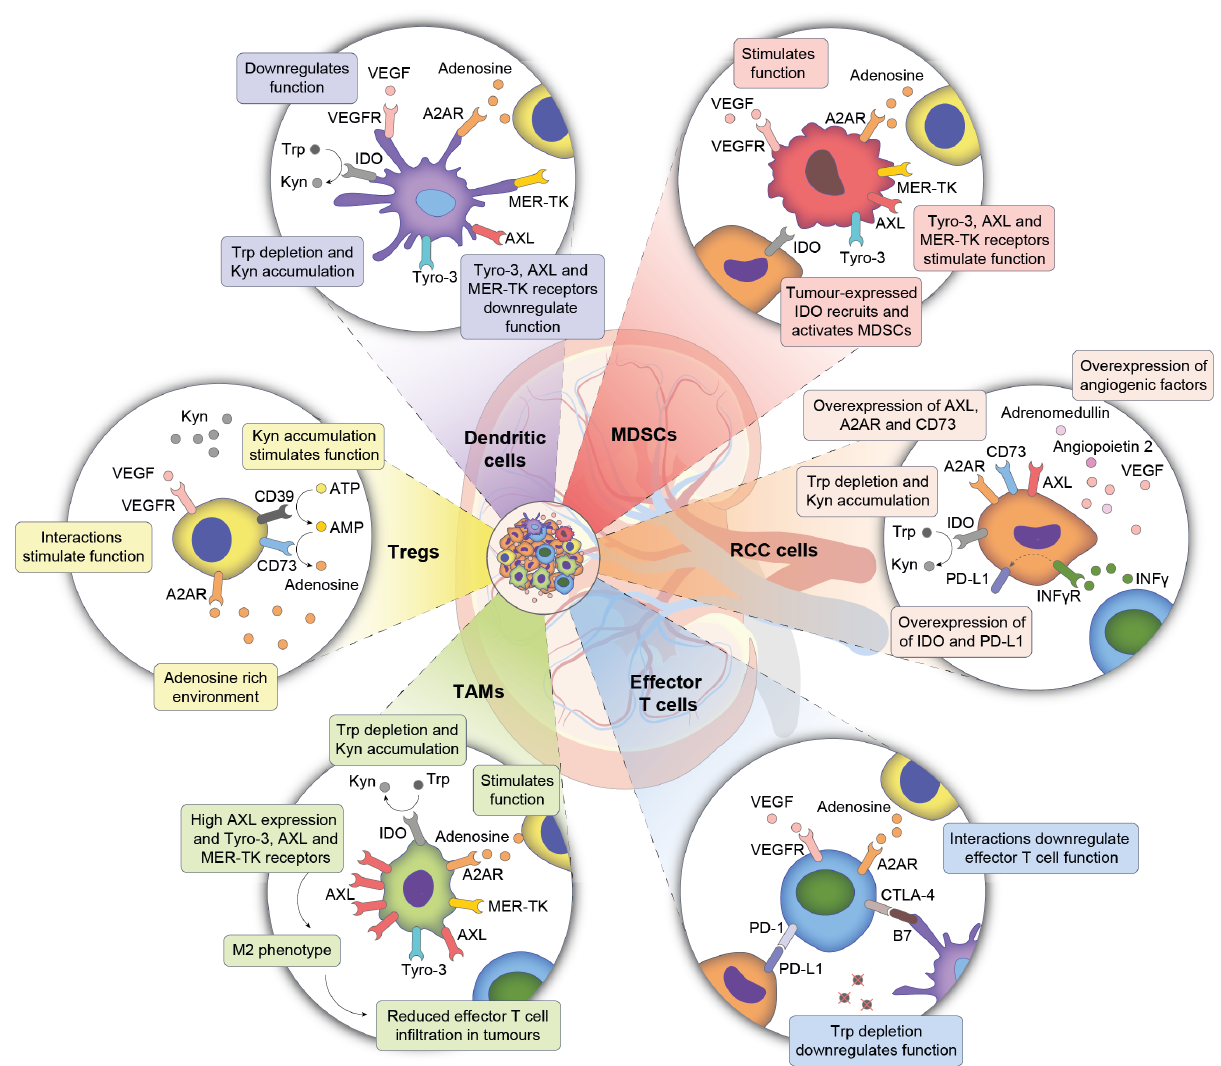
Figure 1. Interactions of clear cell RCC and the tumour microenvironment. A2AR, adenosine A2A receptor; AMP, adenosine monophosphate; ATP, adenosine triphosphate; CD, cluster of differentia- tion; CTLA-4, cytotoxic T-lymphocyte-associated protein 4; IDO, indoleamine 2,3-dioxygenase; IFN γ , interferon gamma; IFN γ R, IFN γ receptor; Kyn, kynurenine; M2 phenotype, alternatively-activated phenotype; MDSC, myeloid-derived suppressor cell; MER-TK, MER proto-oncogene, tyrosine kinase; PD-1, programmed cell death protein 1; PD-L1, programmed death-ligand 1; RCC, renal cell carcinoma; TAM, tumor-associated macrophage; Treg, regulatory T cell; Trp, tryptophan; Tyro-3, tyrosine-protein kinase receptor TYRO3; VEGF, vascular endothelial growth factor; VEGFR, VEGF receptor. Expression of Tyro-3, MER-TK and AXL also occurs on tumour-associated macrophages. High AXL expression is associated with a shift towards an M2, immunosuppressive phe- notype, and a decrease in effector immune cell infiltration in the RCC tumour microen- vironment [27,38,39]. Microenvironmental adenosine, which is generated via CD39 and CD73 mediated conversion of adenosine triphosphate to adenosine (Figure 1), inhibits the antitumor function of various immune cells, including components of the adaptive and innate immune systems, by binding to cell surface A2AR [40–42]. Conversely, A2AR enhances the immunosuppressive activity of myeloid and regulatory T cells